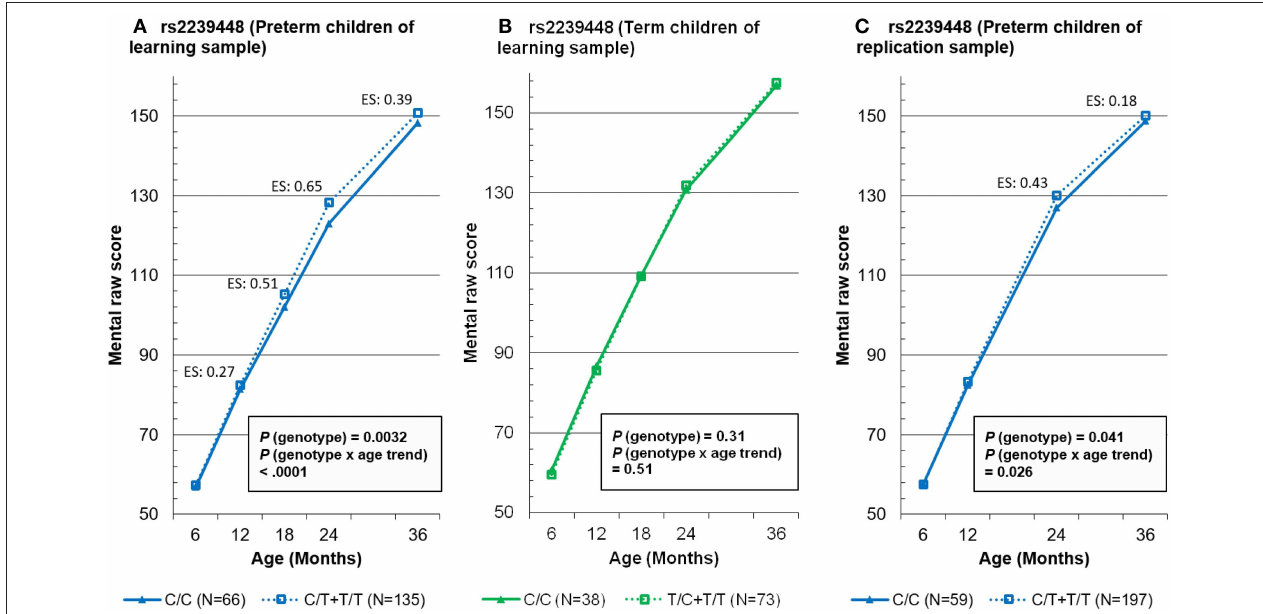
FIGURE 1 | Mixed-effects model-based mental raw score at 5 time points by the genotypes of MAOA tag rs2239448 in preterm and term children in the learning sample ( A,B , respectively) and in preterm children in the replication sample (C) . ES, effect